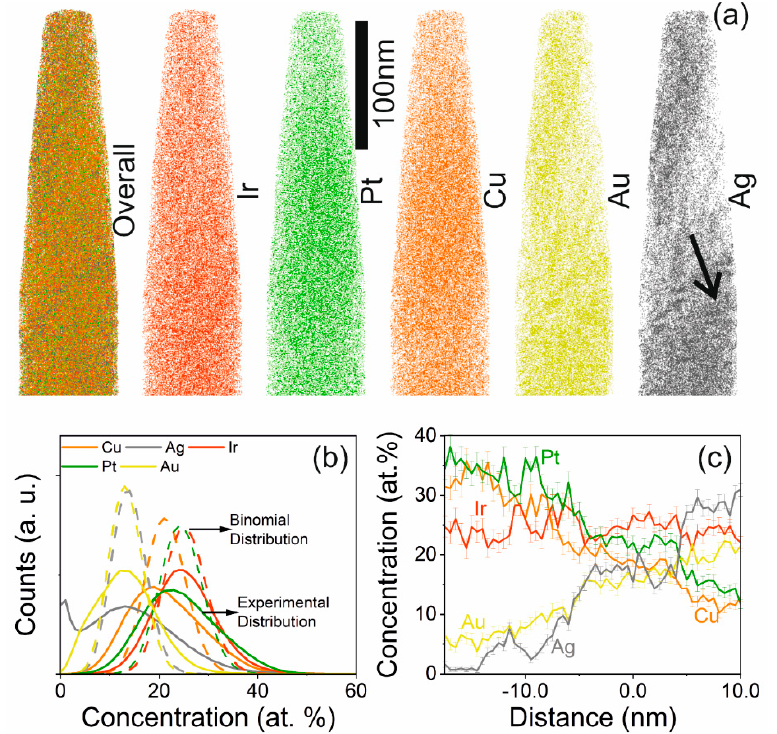
Figure 3. ( a ) Depiction of the overall as well as individual elemental distribution of Pt 22 Ir 23 Cu 20 Au 17 Ag 18 , via atom probe tomography. ( b ) Frequency distribution analysis of the constituting elements. ( c ) The one-dimensional concentration profile along the direction highlighted in ( a ), depicting the 2 phases: Au-Ag-depleted and -rich regions.